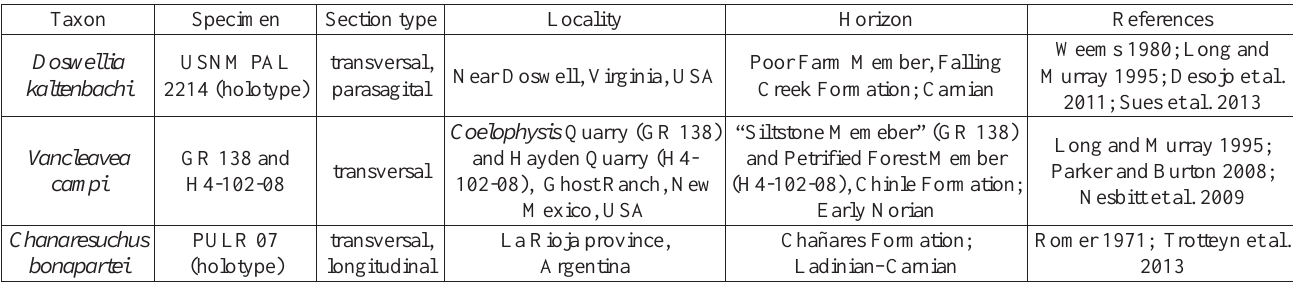
Table 1. Histological sections of osteoderms referred in the the current